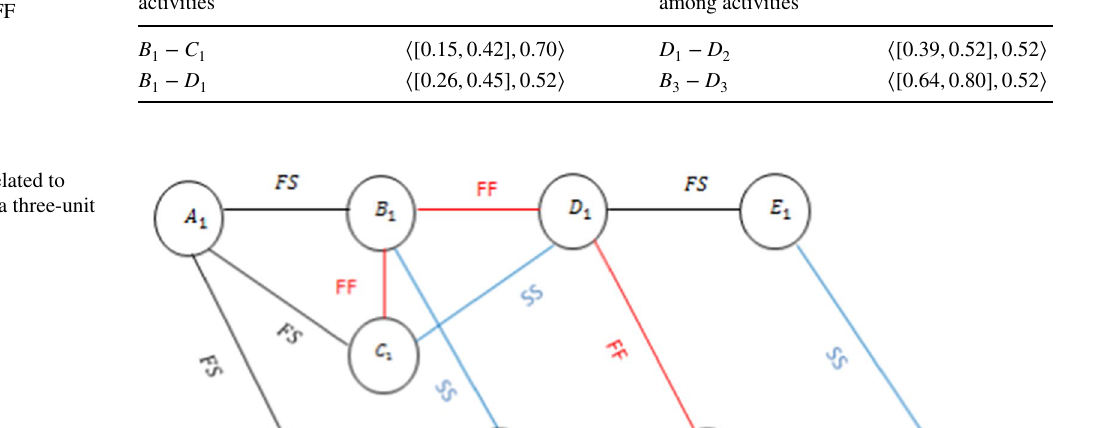
Relationships among Cubic fuzzy values